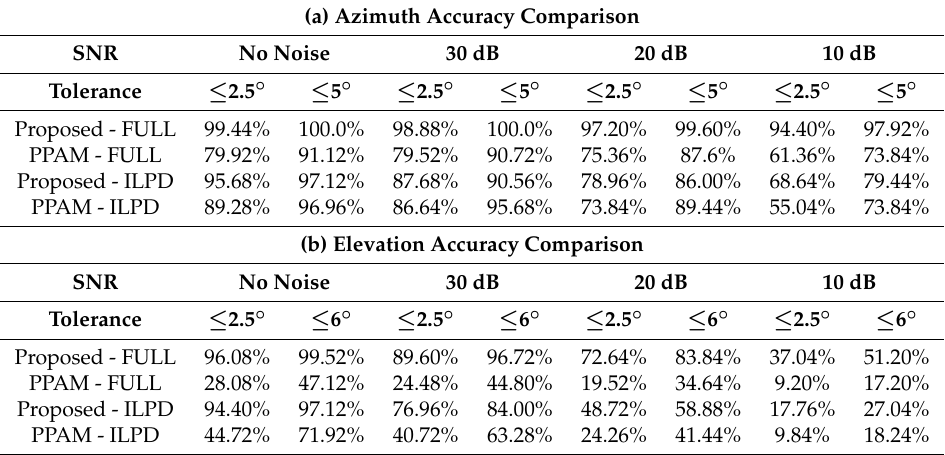
Figure 8. Comparing the localization accuracy between proposed and PPAM methods using different feature vector types. The angular error tolerance is 2.5 ◦ . Table 2. Azimuth and elevation estimation accuracy comparison in noisy